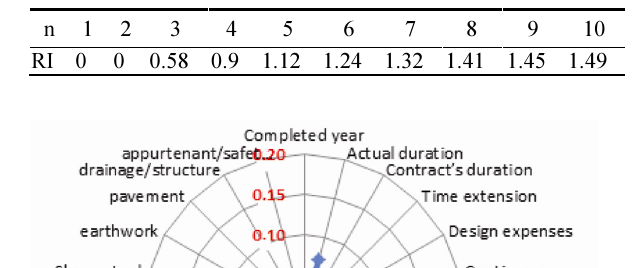
Table 5. Random consistency index (Saaty 1990)